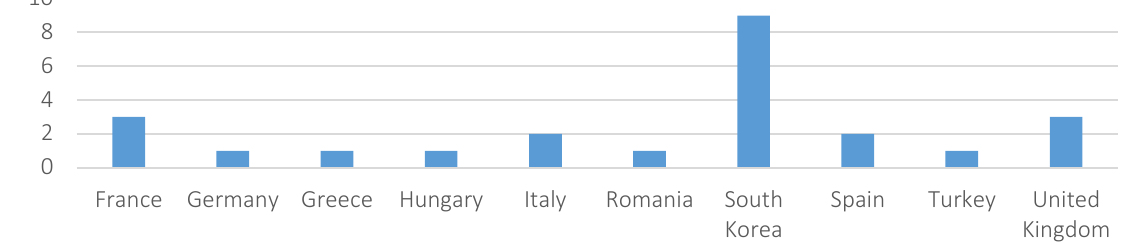
Figure 3. The number of requests for cooperation profile country of origin for